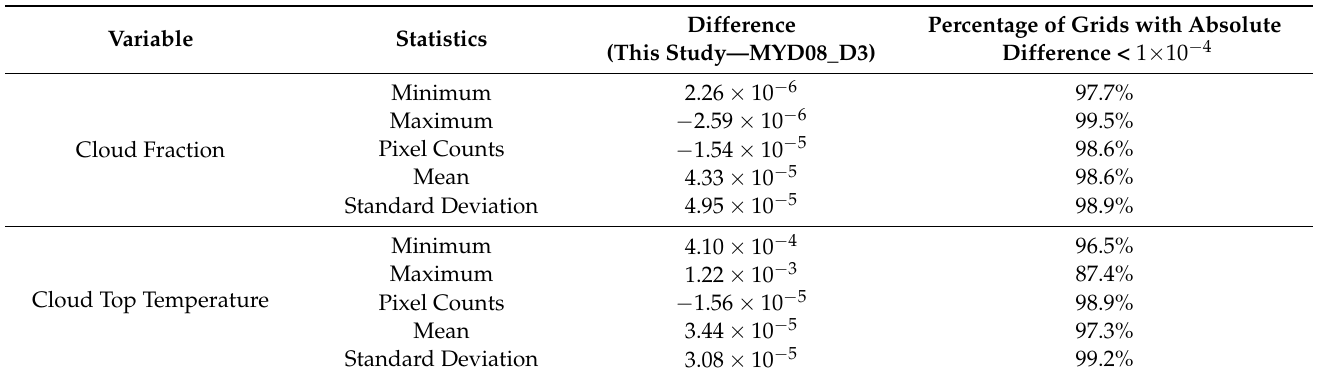
Table 3. The globally averaged differences of the statistics of cloud fraction and cloud top temperatures between the python-based flexible aggregation and the MYD08_D3 product on 1 January 2008.